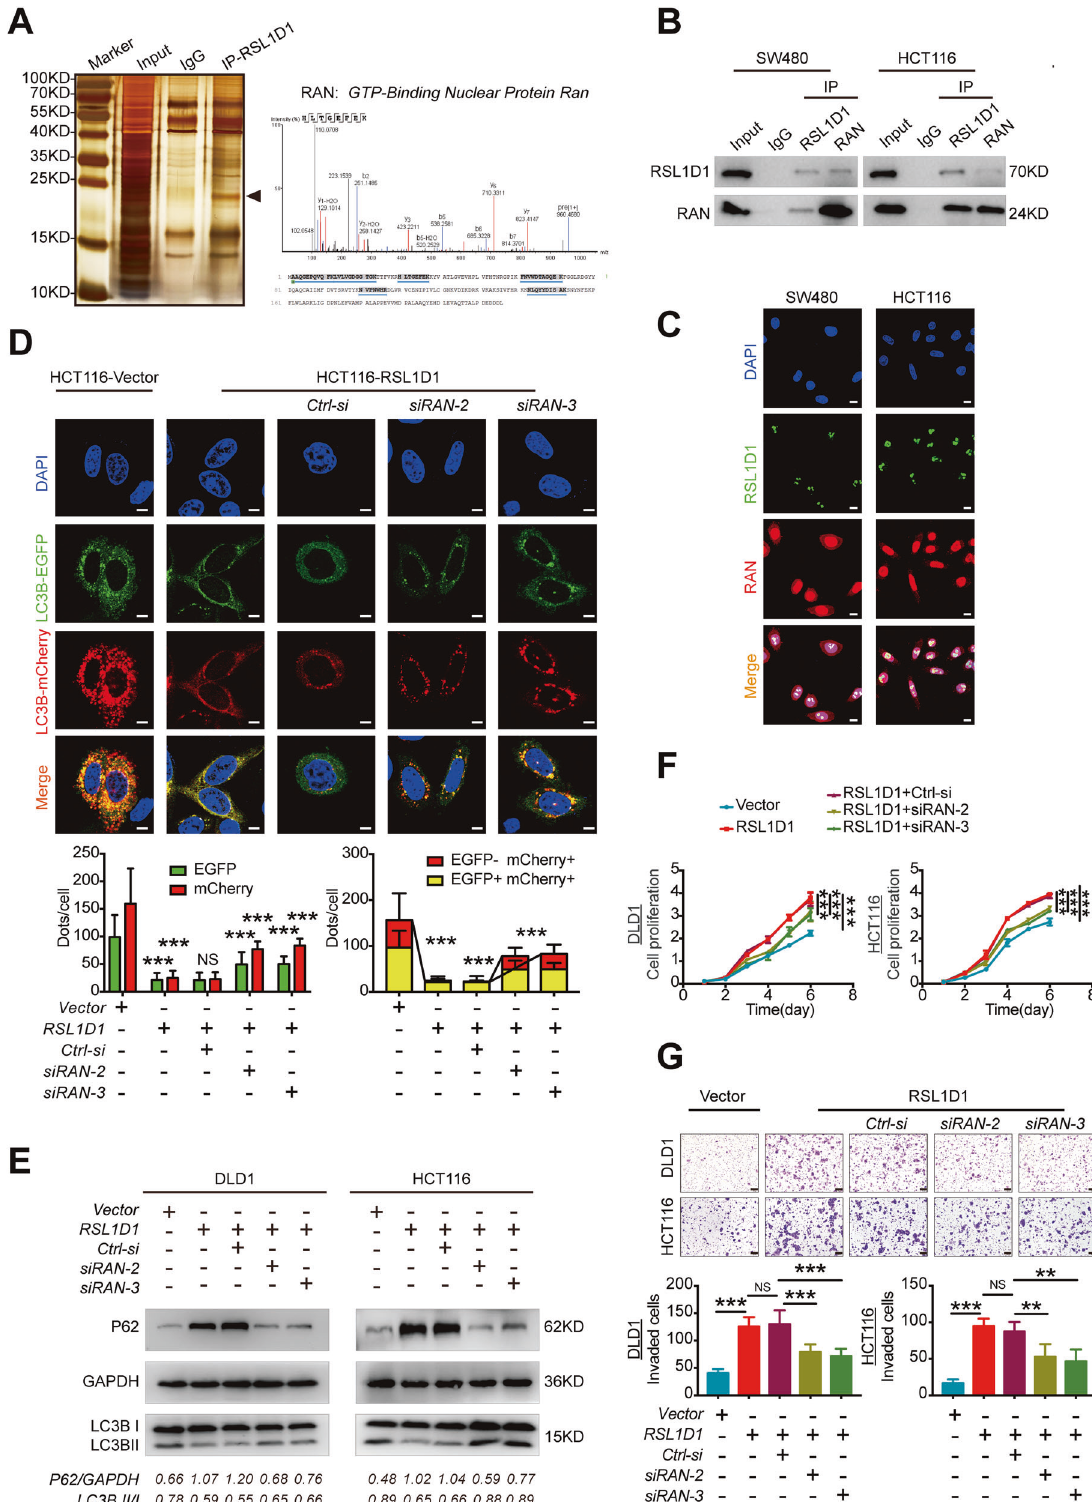
Fig. 5 The interaction between RSL1D1 and RAN is essential for autophagy and the proliferation and invasion of CRC cells. A Co-IP combined with LC-MS/MS analysis was used to analyze the interacting proteins of RSL1D1 in CRC cells; RAN, a ras-related nuclear protein, was identi fi ed. B Co-IP of endogenous RSL1D1 and RAN proteins in CRC cells. C Double IF staining revealed the colocalization of RSL1D1 and RAN proteins in CRC cells. Scale bar, 10 µm. D The autophagic fl ux of CRC cells with stable RSL1D1 knockdown and transient RAN knockdown under starvation conditions was monitored by the mCherry-EGFP-LC3B assay. Scale bar, 50 µm. E Protein expression of LC3-II and P62 was examined by WB in CRC cells with stable RSL1D1 knockdown and transient RAN knockdown under starvation conditions. F – G . CCK-8 [ F ] and Transwell invasion assays [ G ] were used to detect the proliferation and invasion of CRC cells after stable RSL1D1 knockdown and transient RAN knockdown. Scale bar, 50 µm. * P < 0.05, ** P < 0.01, *** P < 0.001, NS means no statistic difference. The error bars represent mean ± SD. Cell Death and Disease (2022)